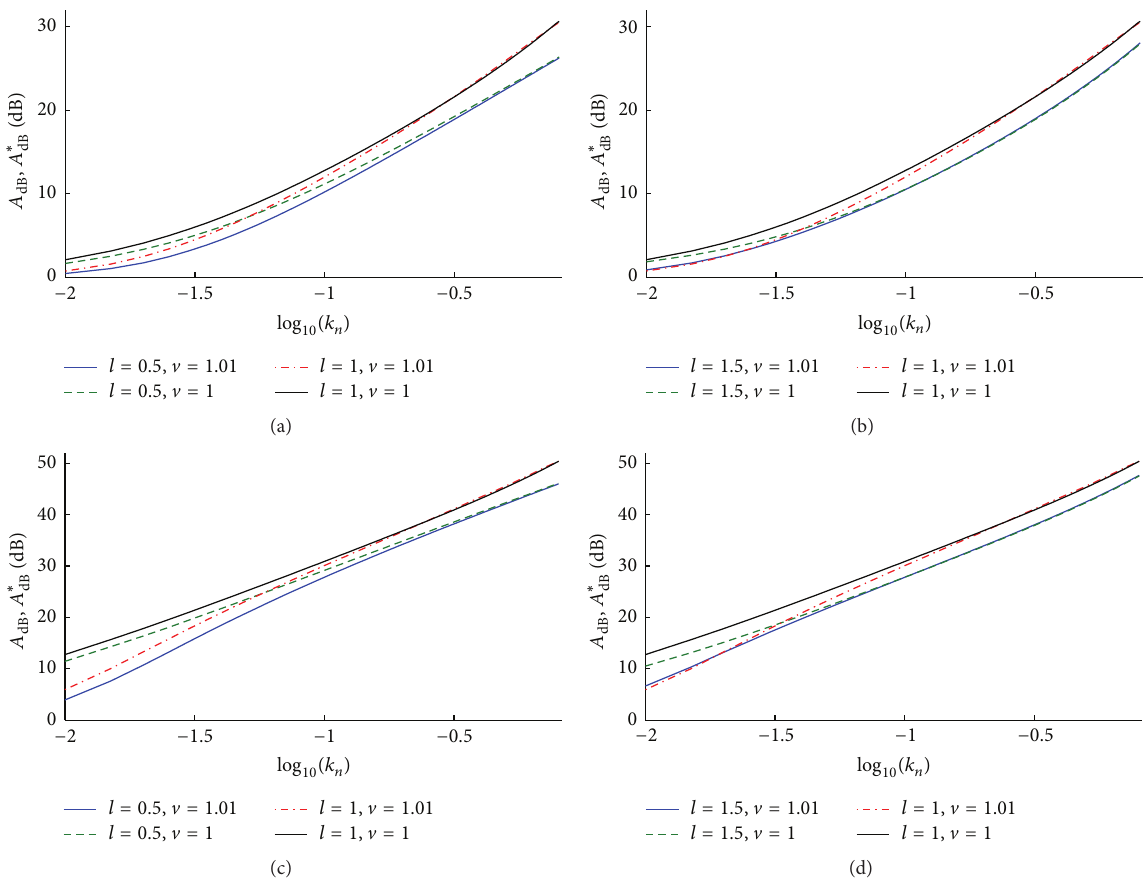
Figure 9: Relationship between 𝐴 dB or 𝐴 ∗ dB and log 10 𝑘 𝑛 for different 𝜉 𝑛 values, 𝑙 , and V : 𝜉 𝑛 = 1%, 𝑙 = 0.5, and V = 1.01 (a), 𝜉 𝑛 = 1%, 𝑙 = 1.5, and = 0.1%, 𝑙 = 0.5, and V = 1.01 (c), and 𝜉 = 0.1%, 𝑙 = 1.5, and V = 1.01 V = 1.01 (b), 𝜉 𝑛 𝑛